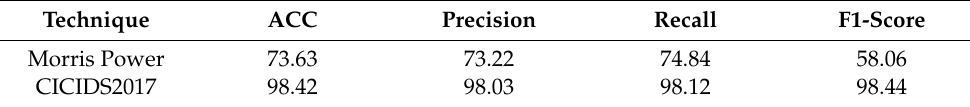
Table 2. Evaluation metrics for the unbalanced datasets.